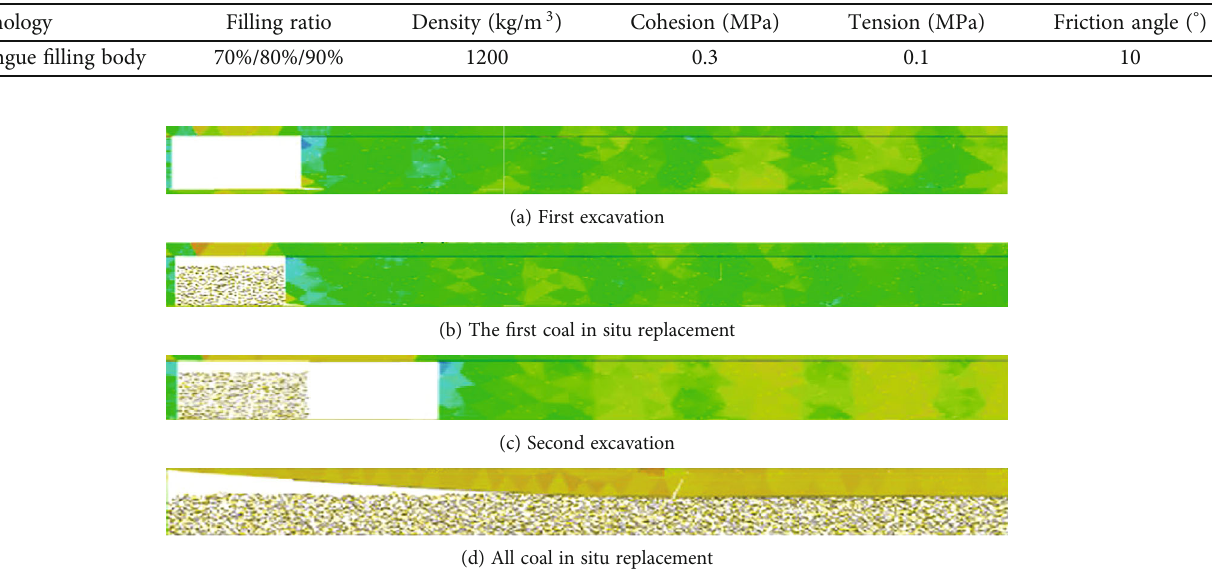
Table 2: Gangue material parameters.